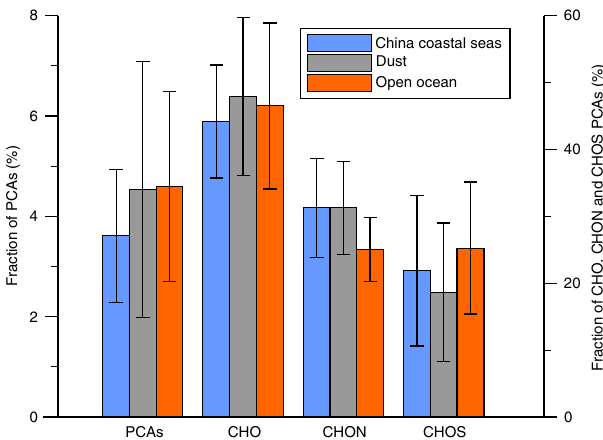
Fig. 3 The fraction of polycyclic aromatic compounds in the different types of aerosols. The left vertical axis refers to the fraction of polycyclic aromatic compounds (PCAs, % of total signal intensity), whereas the right vertical axis indicates the fraction of different PCAs (CHO, CHON, and CHOS) in different aerosol types. Error bars show 1 s.d. of the average values for each sample group. CHO: compounds composed of C, H, and O; CHON: compounds composed of C, H, O, and N; CHOS: compounds composed of C, H, O, and